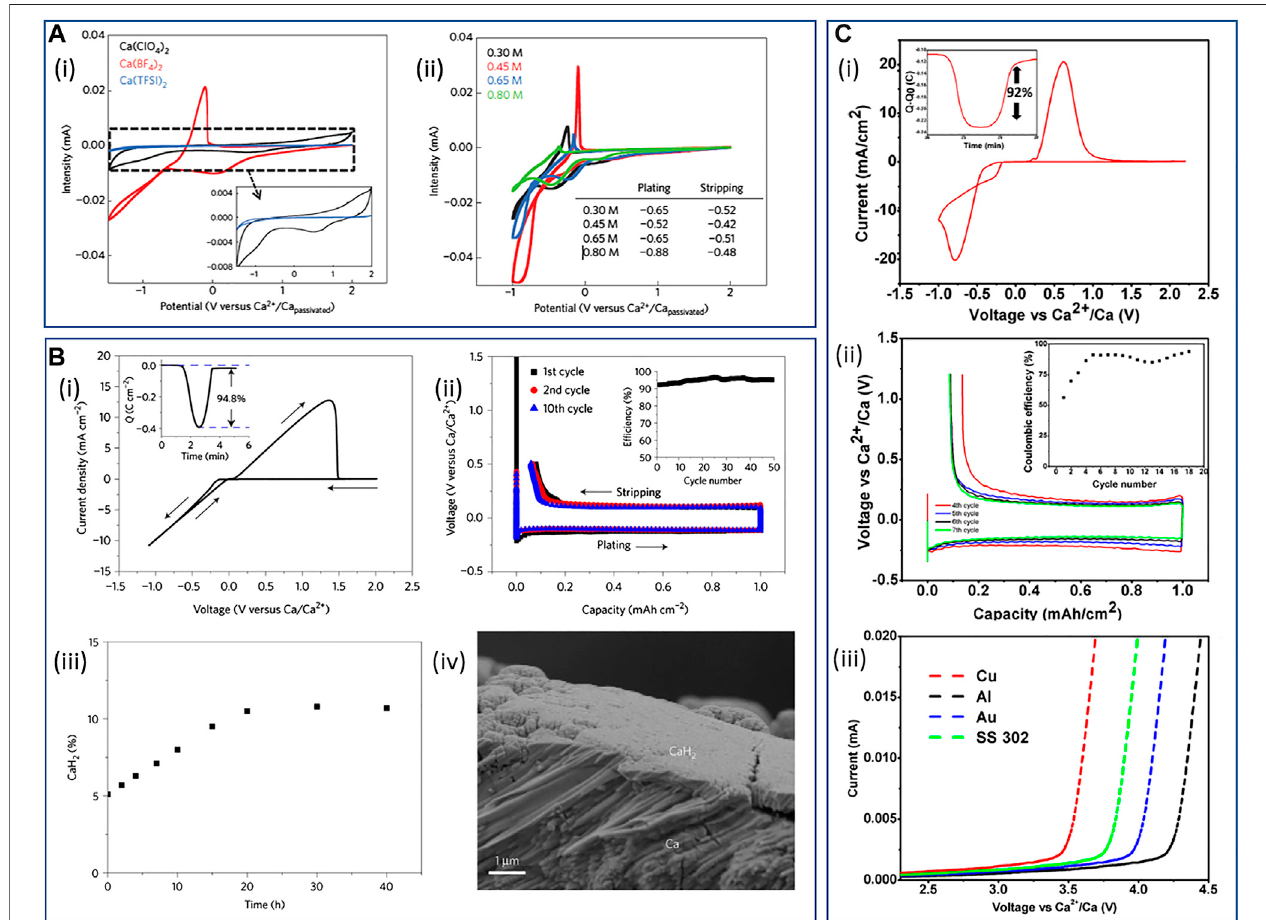
FIGURE 4| (A) Cyclic voltammograms of EC:PC-based electrolytes (0.5 mV s − 1 scan rate) at 100 ° Cwith (i) a0.3 M concentration ofdifferent Ca 2+ salts and (ii) a range of Ca[BF 4 ] 2 concentrations from 0.3 to 0.8 M. Reproduced with permission from (Ponrouch et al., 2016). (B) Calcium plating/stripping in 1.5 M Ca[BH 4 ] 2 /THF; (i) Cyclic voltammogram of calcium plating/stripping. The working, reference, and counter electrode are Au, Ca, and Pt, respectively. Scan rate 25 mV s − 1 . Inset shows charge passed on plating/stripping from the CV. (ii) Galvanostatic calcium plating/stripping at a rate of 1 mA cm − 2 (iR-corrected). The working, reference, and counter electrode are Au, Ca, and Ca, respectively. (iii) Accumulation of CaH 2 at open circuit after depositing 1 mAh cm − 2 of calcium on the electrode, expressed as a mole percentage ofthe charge passed and (iv) the cross-sectional image of the electrode after 20 h rest at open circuit. Reproduced with permission from (Wang et al., 2018a). (C) ElectrochemicalmeasurementsinCa[B(Oh fi p) 4 ] 2 /DMEelectrolyte: (i) fourthCVcycleonanAusubstratewithcalciumasthereferenceandcounterelectrode (scan rate of 25 mV s − 1 ); (ii) galvanostatic plating/stripping of calcium on an Au electrode with Ca counter- and reference electrodes at 0.2 mA cm − 2 to a capacity of 1 mAh cm − 2 ; (iii) linear sweep voltammograms recorded on various substrates at a scan rate of 0.05 mV s − 1 with Ca as both the reference and